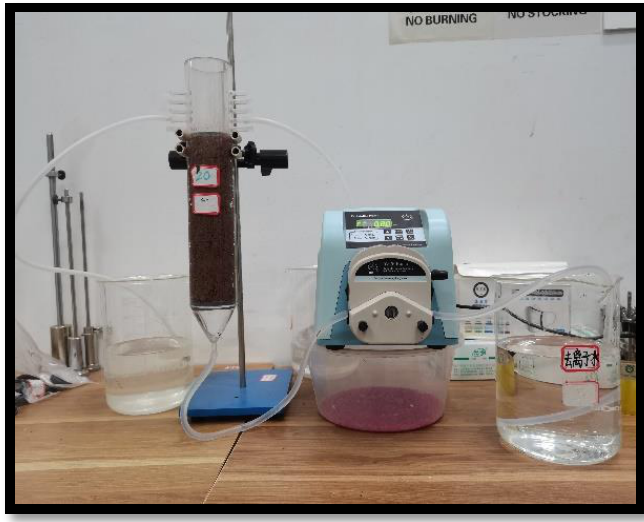
Figure 4. Experimental equipment for soil column leaching test. Figure 4 . Experimental equipment for soil column leaching test. Samples were saturated with deionized water to remove all of the air prior to the experiments. After the samples were saturated, a D100 easy-install peristaltic pump (Shanghai Huxi Analytical Instrument Factory Co., Ltd.) was used to supply water at a constant speed. A tracer element of 0.1 mol/L potassium bromide was also added. Once the lower end of the soil column was exuding water steadily, the outflow liquid was collected. Based on the change in the magnitude of change in outflow liquid concentration, the water collection interval was then changed, however. Eventually, when the bromide ion concentration in the outflow liquid fluctuated around 0.1 mol/L, the experiment was ended. The longitudinal migration coefficient (D) was then obtained after data